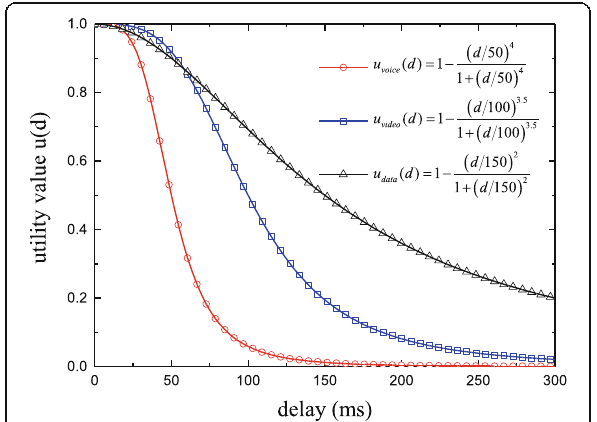
Fig. 6 Delay jitter utility function curve for voice, video, and data applications